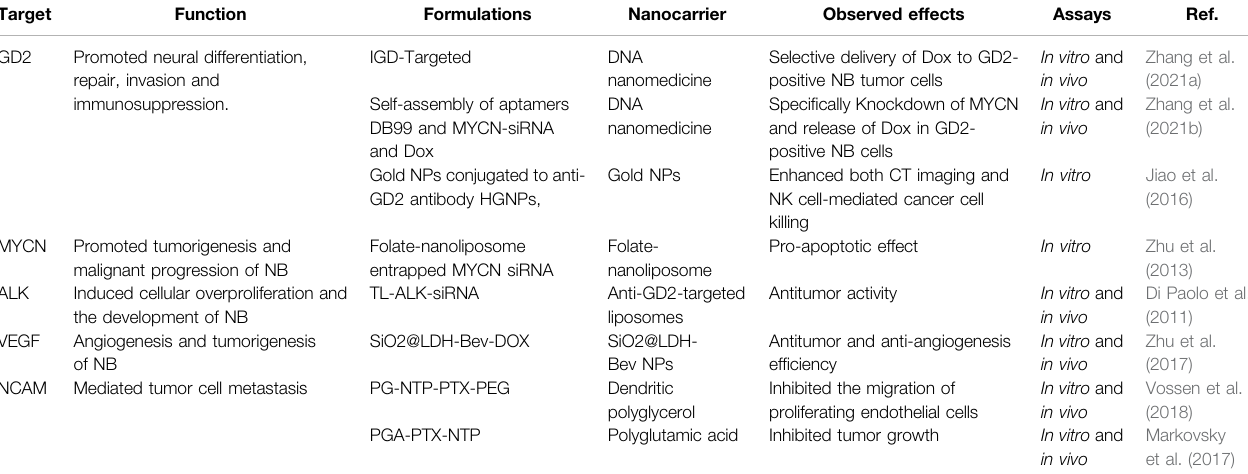
TABLE 3 | Summary of nanocomposite applications of potential targets available for NB diagnosis or